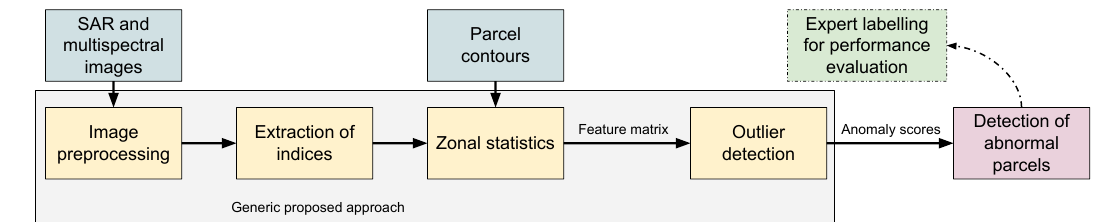
Figure 3. Diagram summarizing the methodological steps for the detection of anomalous crop development.